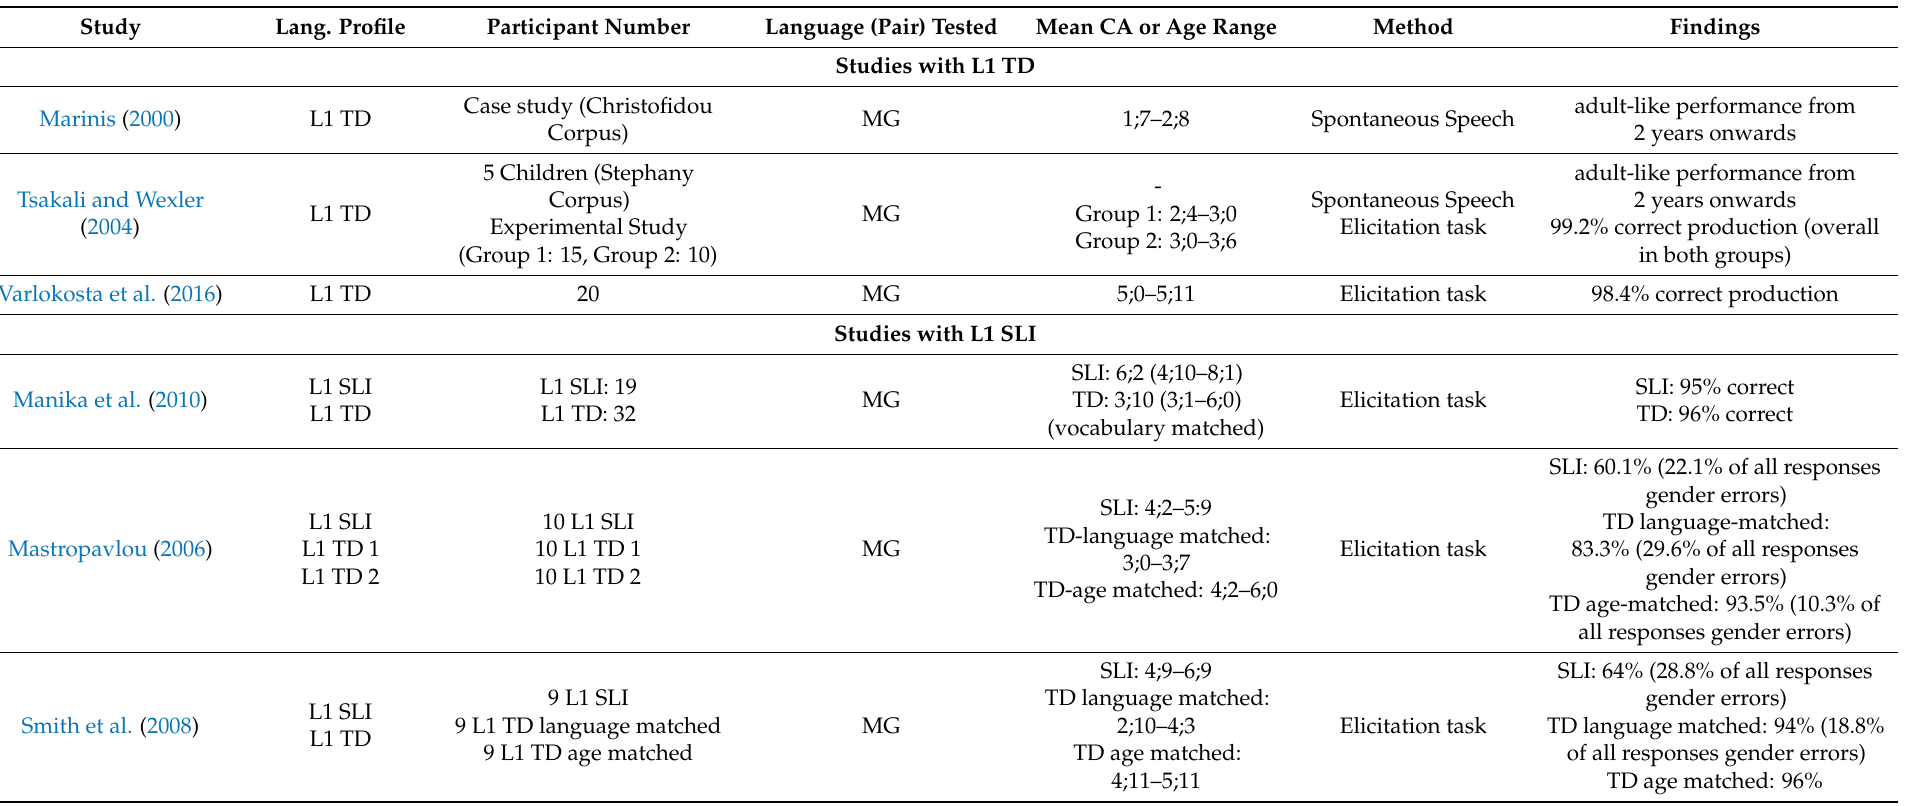
Table 2. Studies on the monolingual or bilingual acquisition of clitics of typically developing children and children with Specific Language Impairment in MG. TD: typically developing, SLI: Specific Language Impairment, L1: monolingual, L2: bilingual, MG: modern Greek, RTs: reaction times, CA: chronological age. The age range is in brackets if the mean is